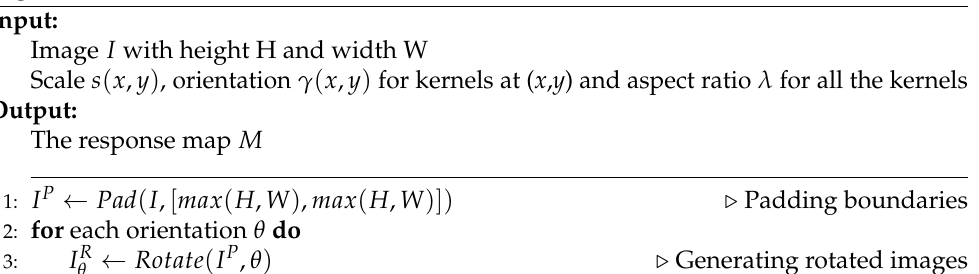
Algorithm 1 Workflow of